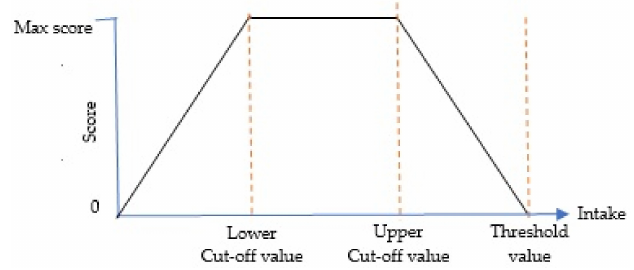
Figure 3. Standard for scoring optimal components.